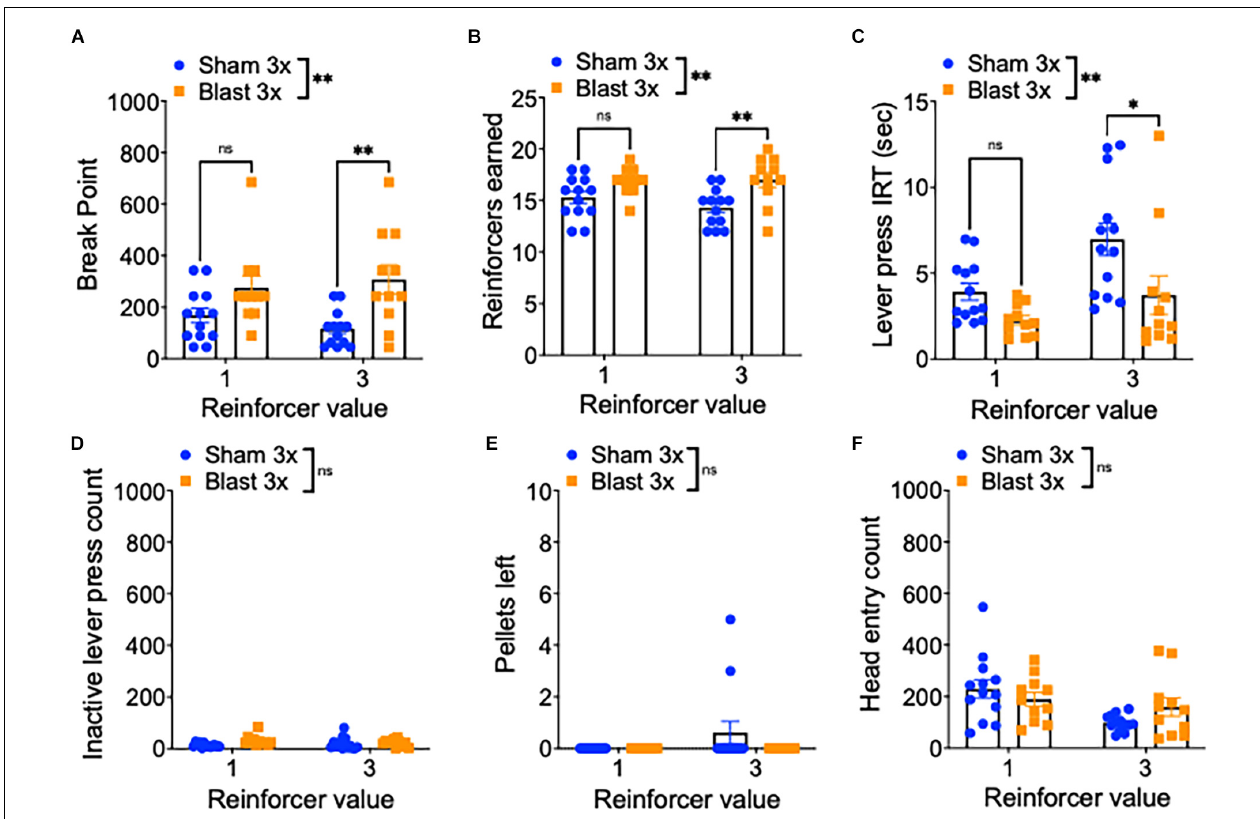
FIGURE 3 | Repetitive blast exposure increases motivation and willingness to work for reward. (A) Progressive ratio break point (last ratio completed). (B) Number of reinforcers earned. (C) Active lever press inter-response time. (D) Number of inactive lever presses. (E) Number of pellets left uneaten. (F) Number of head entries during lever out. Two-way RM ANOVA Bonferroni-Šídák post hoc (A–F) . ∗ p ≤ 0.05, ∗∗ p ≤ 0.01, ns, not significant. Values represent mean ±